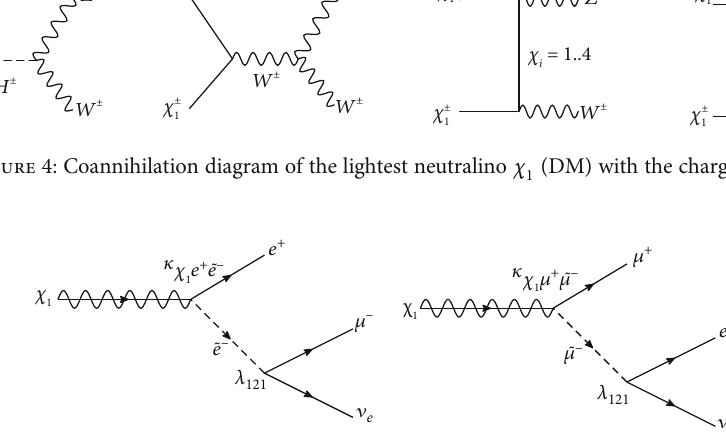
Figure 4: Coannihilation diagram of the lightest neutralino χ